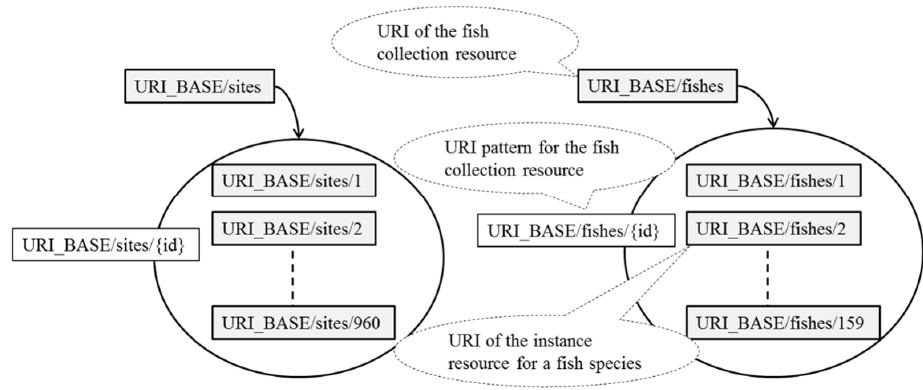
Figure 4. Organization of instance and collection resources. URI_BASE is the common prefix for every URI in OSAEM and is explained in Section 4.2. URI_BASE = http://db.cilaboratory.org:8080/naemp.